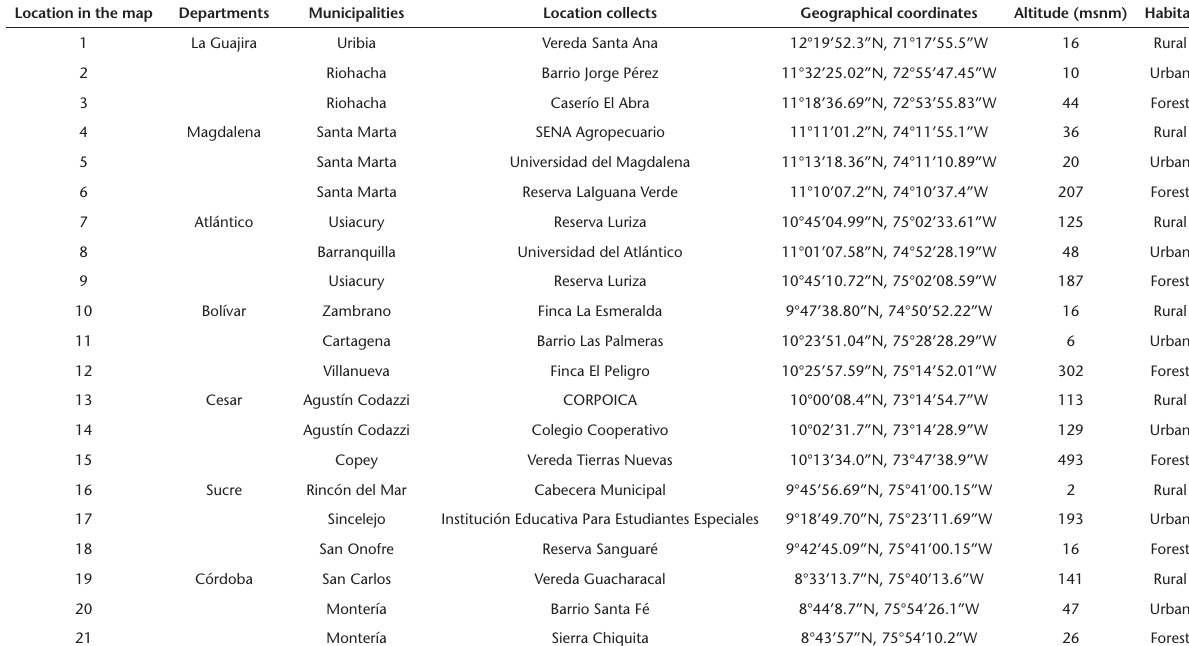
Figure 1. Map with collection localities in the Guajira province, Table 1. Collection localities in the Colombian Guajira province. Location in the map